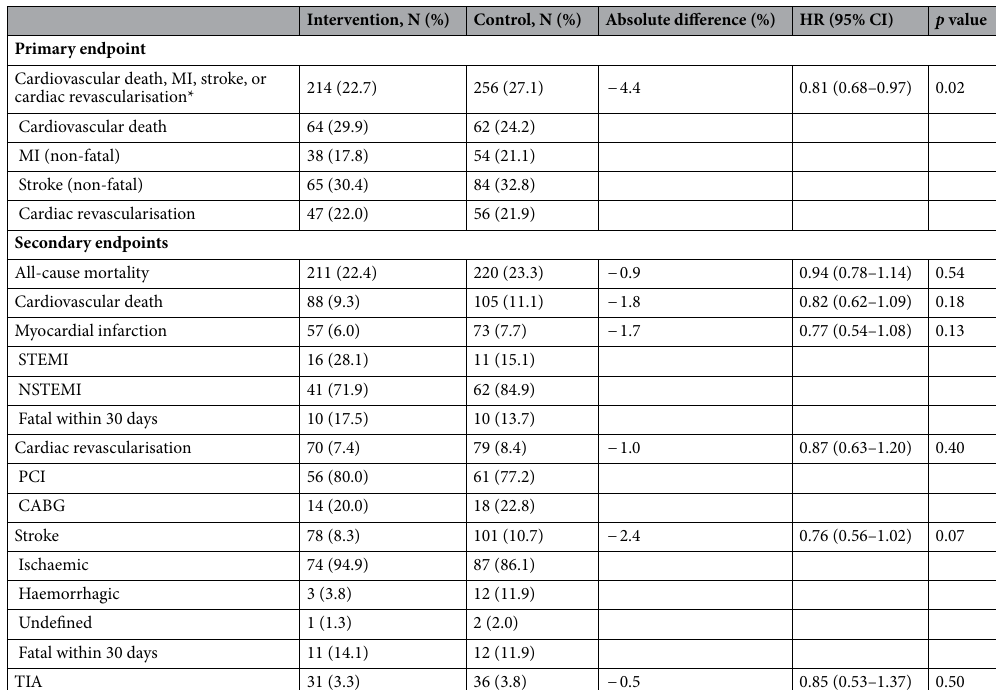
Table 2. Primary and secondary endpoints. The primary endpoint components, subtypes of the secondary endpoints, and fatality are presented as proportions (%) of the main outcome event for each group. MI, Myocardial infarction; STEMI, ST elevation myocardial infarction; NSTEMI, Non-ST elevation myocardial infarction; PCI, Percutaneous coronary intervention; CABG, Coronary artery bypass grafting; TIA, Transient ischemic attack. *The first event to occur was